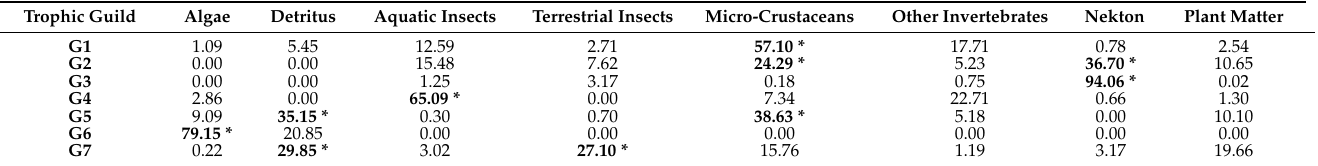
Table 3. Mean value of quantitative mass prey contribution ( w/w %) to the diet of each functional trophic guild group of the Greek freshwater fish species (G1: zooplanktivorous; G2: opportunistic piscivorous; G3: piscivorous G4: insectivorous; G5: opportunistic zooplanktivorous; G6: herbivorous; G7: opportunistic detritivorous). The asterisk (*) denotes the most abundant preys of food in each